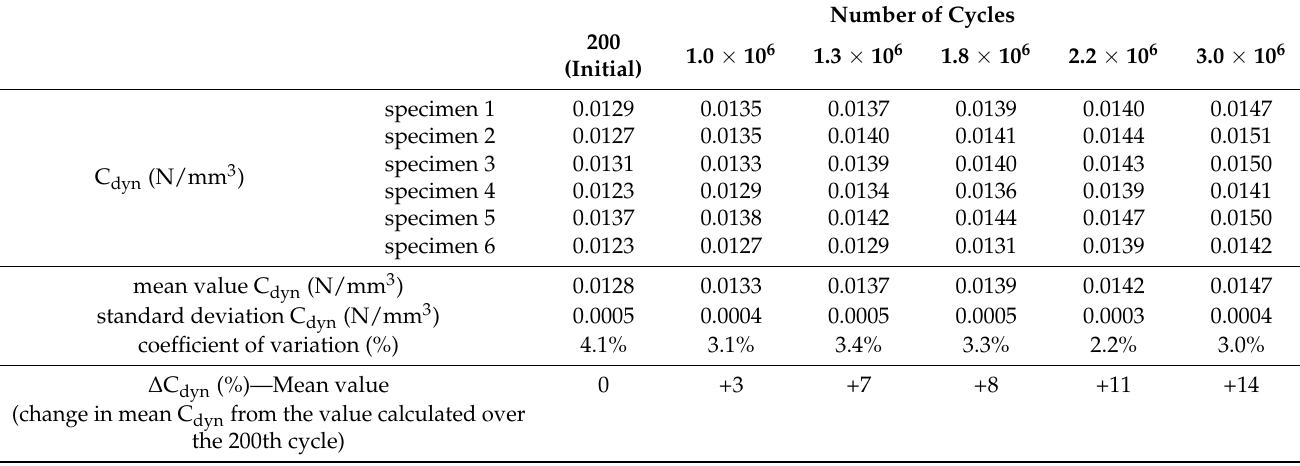
Table 6. Experimental results of the dynamic bedding modulus C dyn as a function of the number of load cycles for Mat